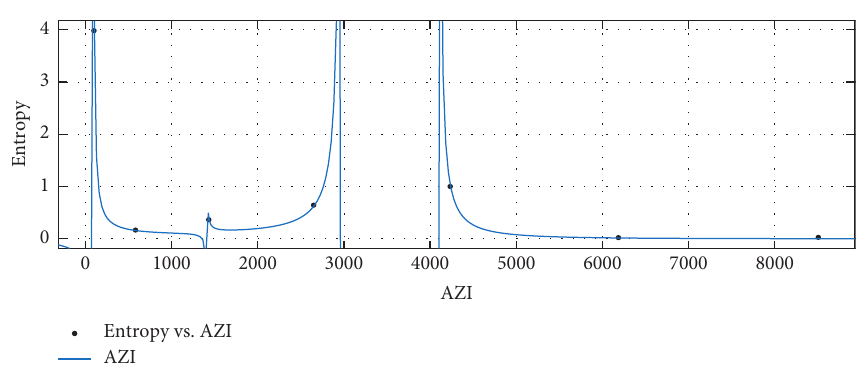
Figure 22: AZI versus